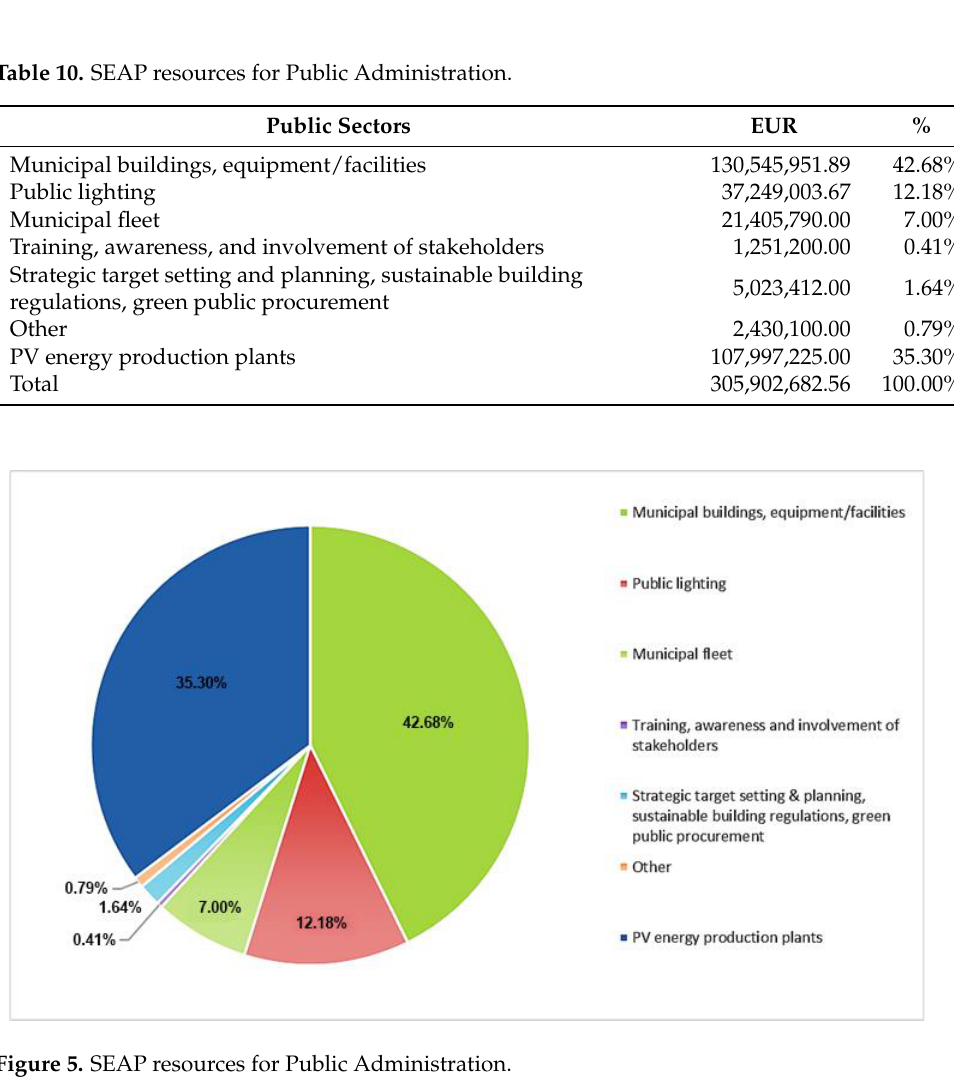
Table 11. Economic budget for SEAPs RES